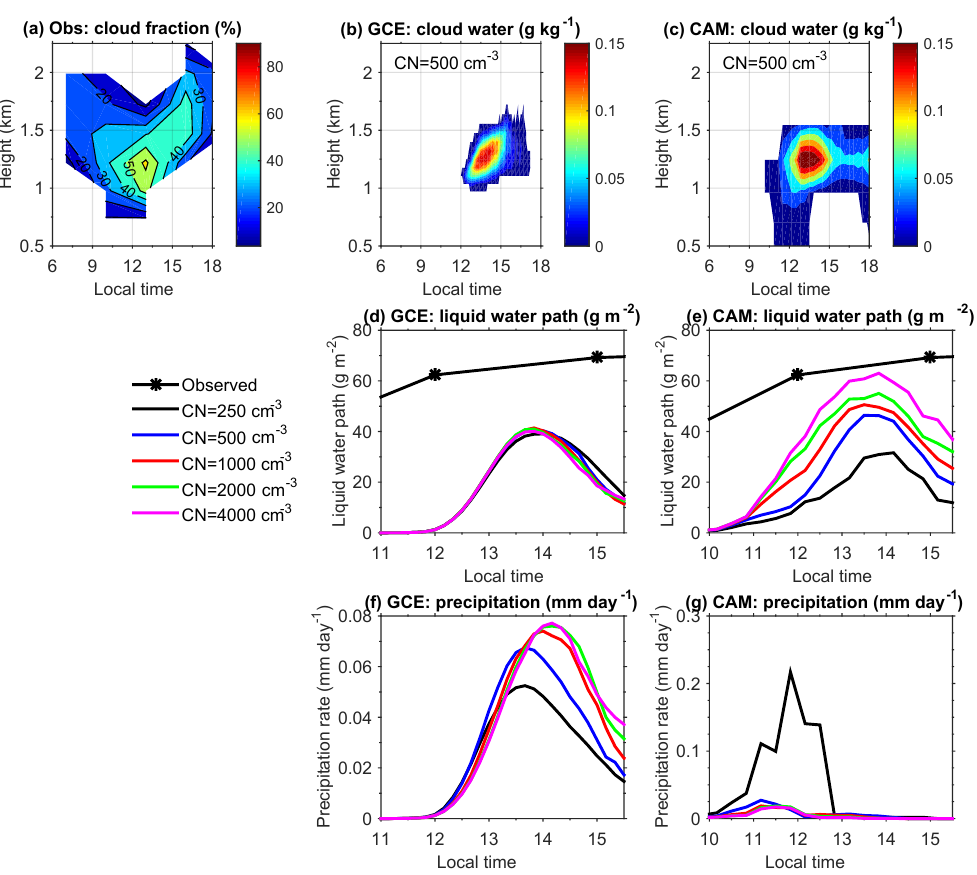
Figure 1. (a) Observed cloud fractions on 27 May 2011 at the SGP site. Domain-averaged cloud water content from the GCE model (b) and the single-column version of CAM (c) for the case assuming a surface aerosol number of 500cm − 3 . Liquid water path and surface precipi- tation rates from GCE (d, f) and CAM (e, g) with varying surface aerosol number